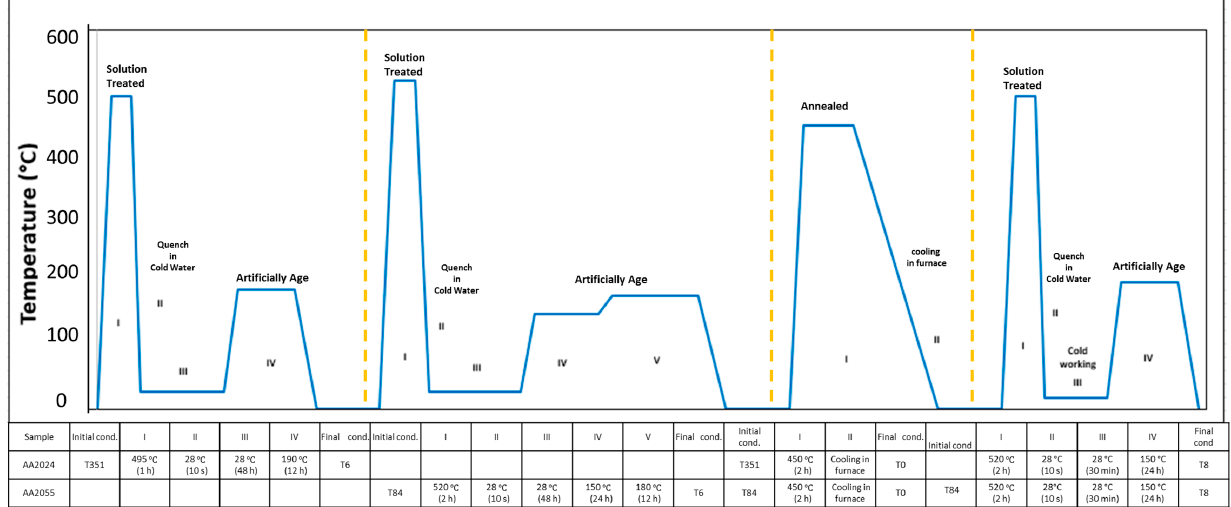
Figure 1. Summary of sequences of temperatures and times for both alloys under different heat treatment conditions.